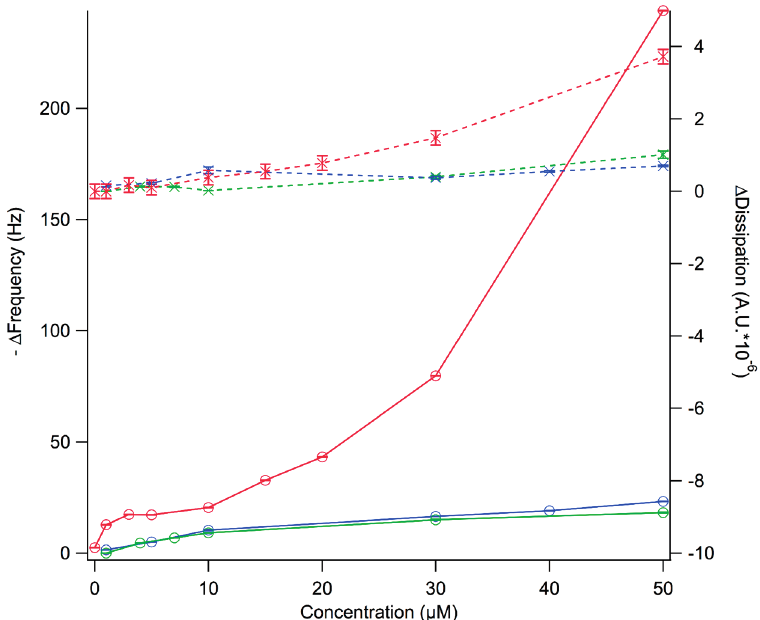
Figure 2. Adsorption isotherms for peptide-based dendrimer D100 (green), D101 (red), and D103 (blue) on silica. ∆ f (circles) and ∆ d (crosses) are plotted as a function of bulk dendrimer concentration. Lines act as guides to the